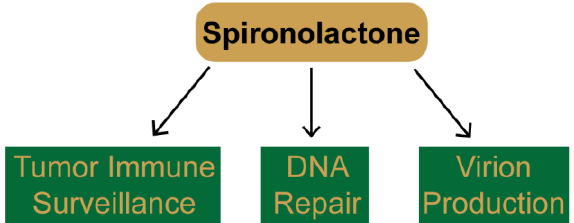
Figure 3. New pharmacological effects of spironolactone uncovered during high-throughput drug screening. Using a variety of different assays, several groups have discovered new functions for spironolactone, including in improving immune recognition by natural killer cells, inhibition of nucleotide excision repair and double-strand break repair, and inhibition of viral transcription and production.